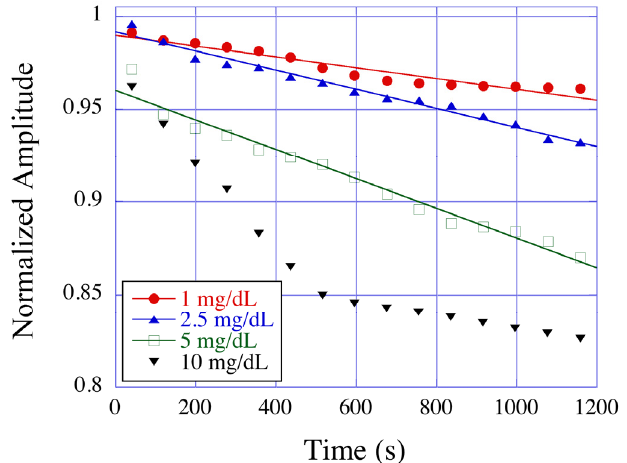
normalized amplitude of an magnetoelastic sensor immersed in LDL solution. Reprinted with permission from